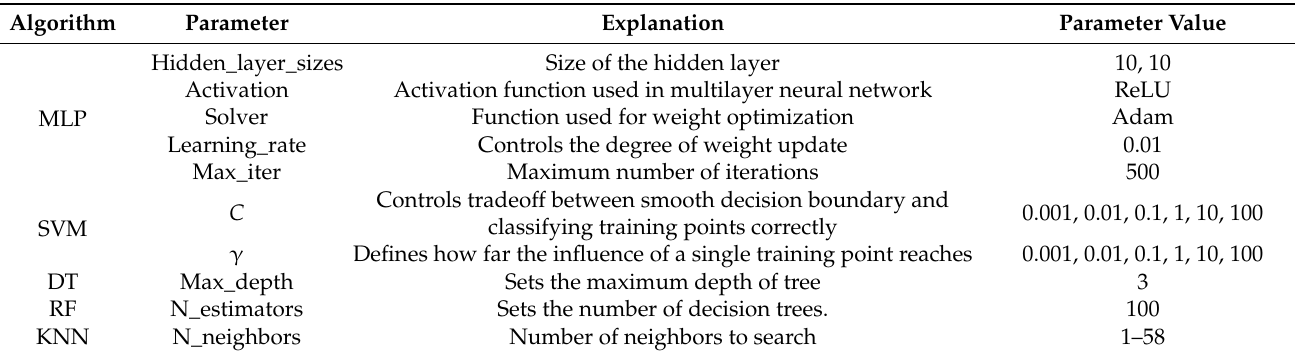
Table 3. Parameters of classification